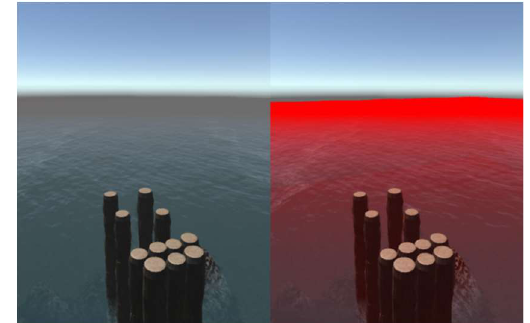
Fig 9 Warning effect on Sea